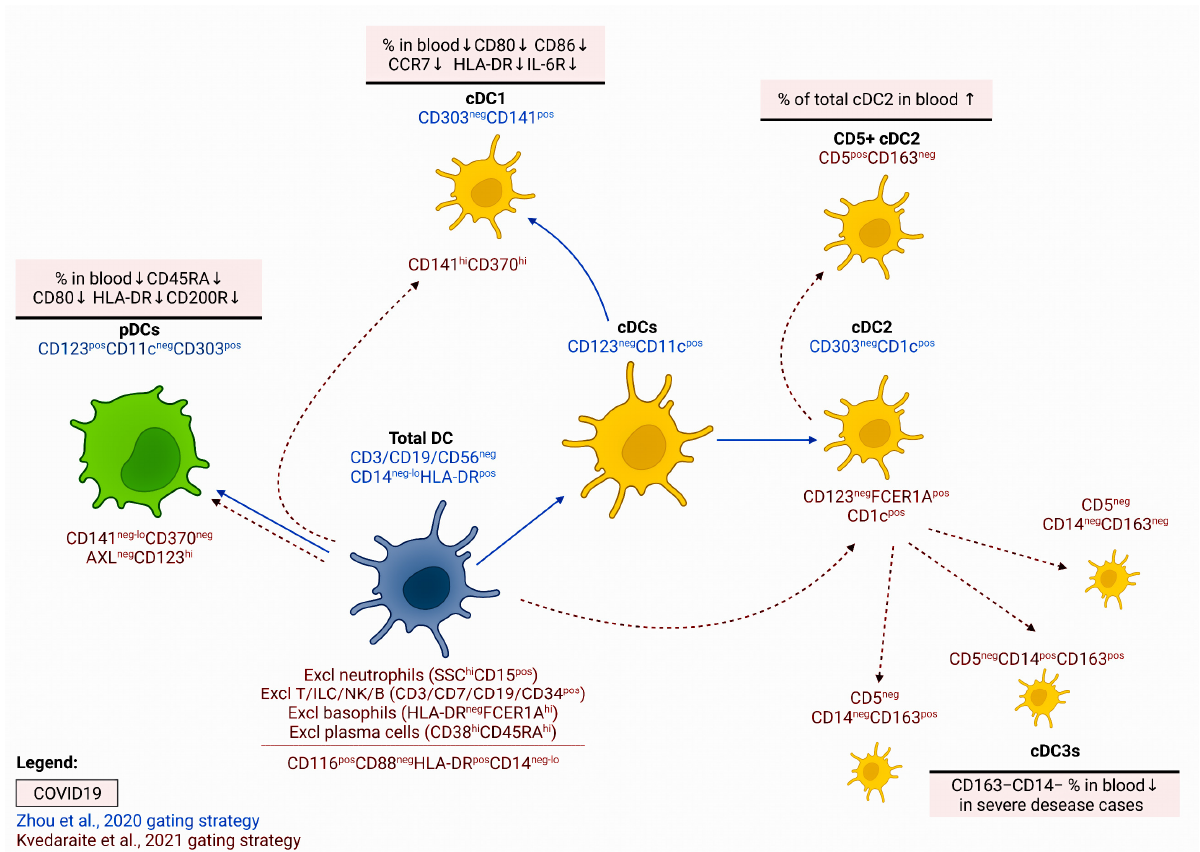
Figure 1. Altered surface phenotype of dendritic cells and their subsets in patients with COVID-19. DCs subsets: cDC1s carry BDCA-3 (CD141), Clec9A, CADM1, BTLA, and CD26 (are capable of cross-presentation of antigens to cytotoxic T-lymphocytes and polarization of ‘naive’ Th cells to Th1); cDC2s are CD1c+ (as well as Fc ε R1+SIRPA+; are capable to initiate responses mediated by various Th cell subsets) [30]; cDC2 can be subdivided into CD5+ DC2 and CD5 − DC3 (consists of several subsets); finally, pDC are CD123+CD11c– and play a crucial role in antiviral response by secreting type I interferons and IL-12 (polarization of Th0 to Th1) [31]. Functional activity of almost all DC subsets can be reduced in severe COVID-19 cases (low levels of MHC molecules and limited costimulatory signaling (a decreased frequency of CD80 and CD86).